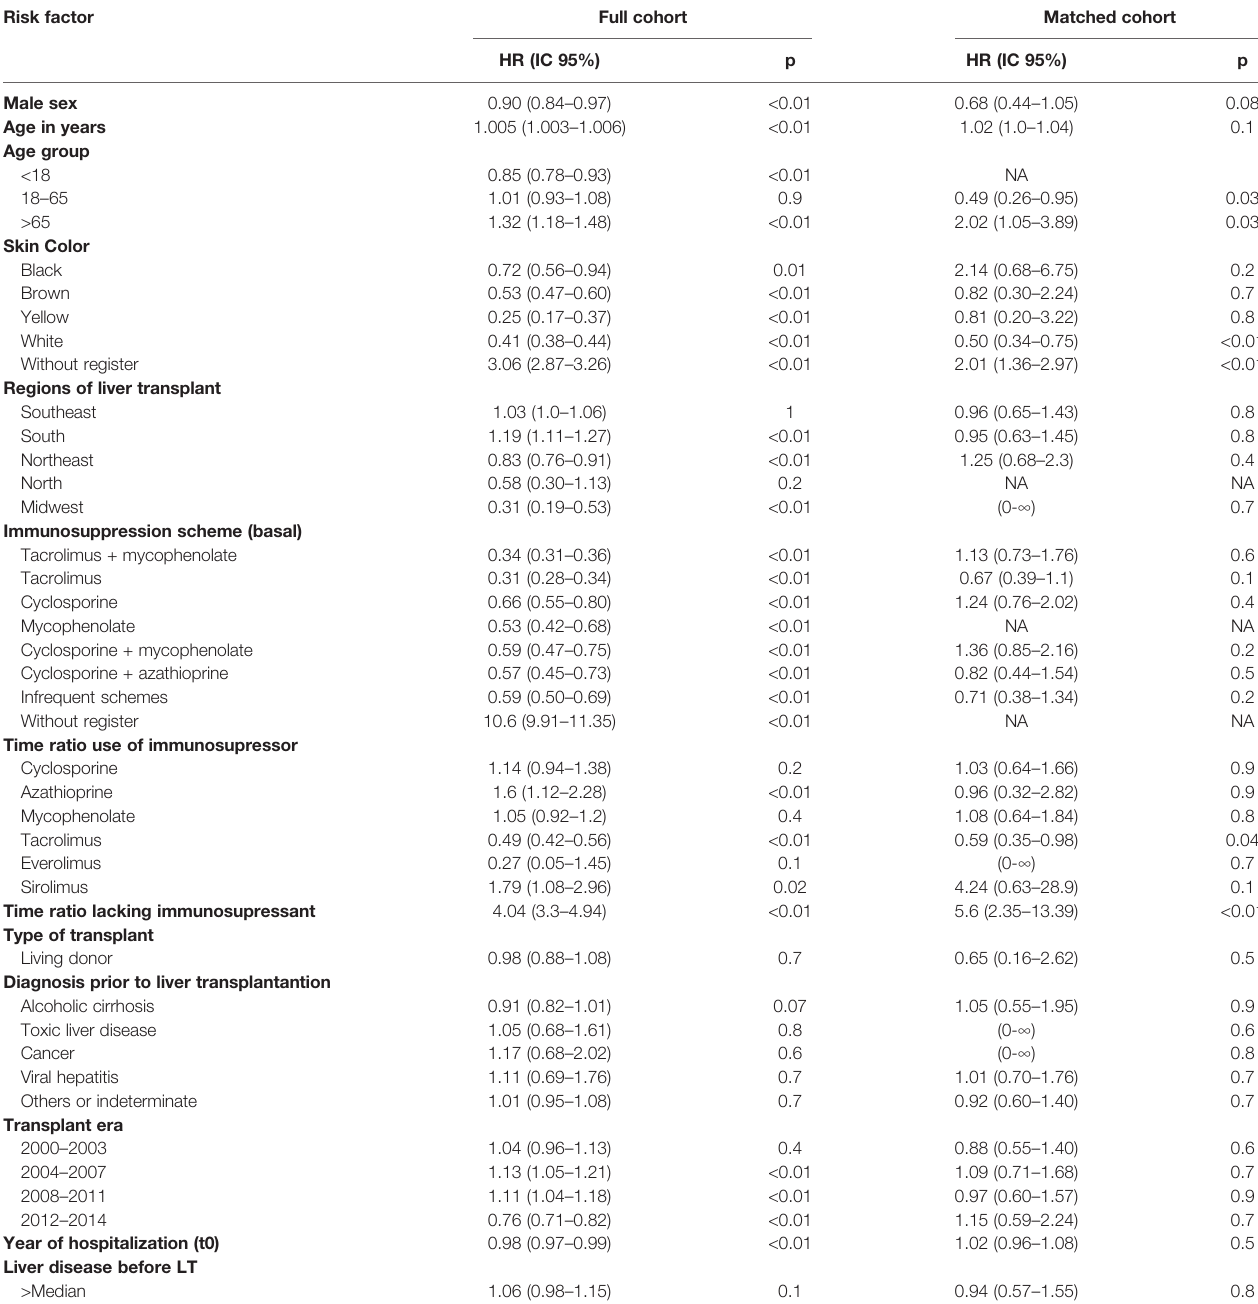
TABLE 3 | Univariate analysis – Risk factors associated with graft